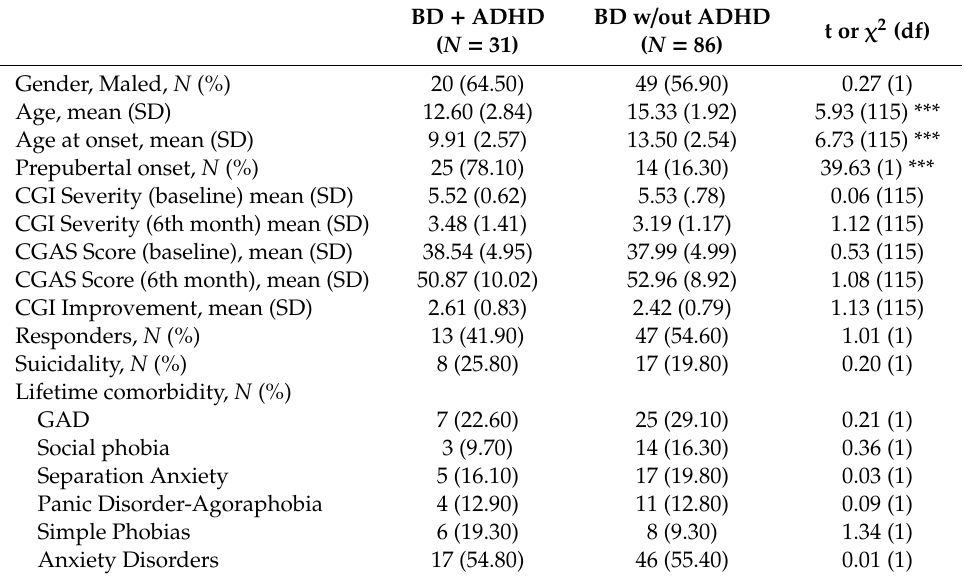
Table 3. Comparison between patients with ( N = 31) and without ( N = 86) attention deficit hyperactivity disorder